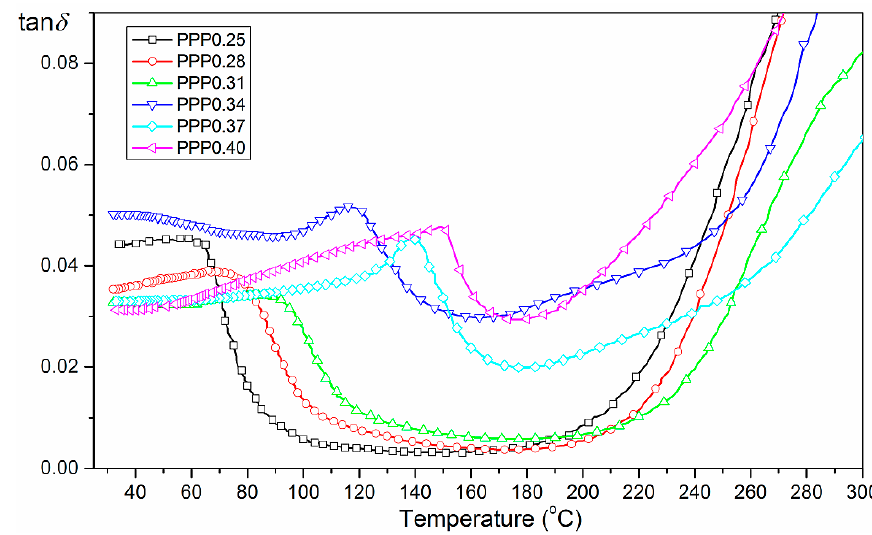
Figure 7. Temperature dependencies tan δ ( T ) for PMN–PT–PS ceramics (cooling cycle for 1 kHz).